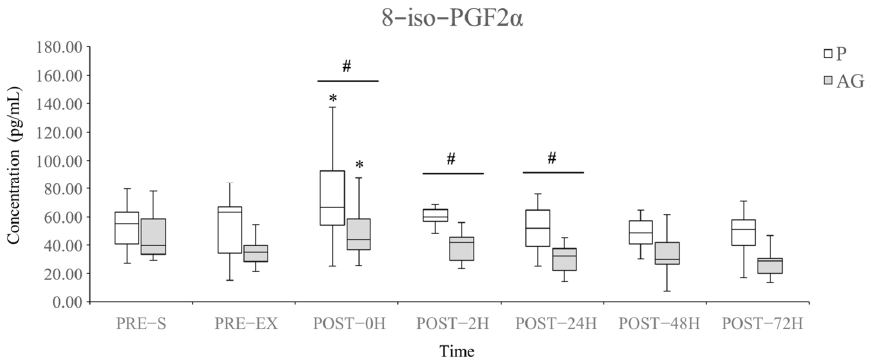
Figure 3. Levels of plasma 8-iso-PGF2 α during the experimental period. Q1, median, Q3, minimum,